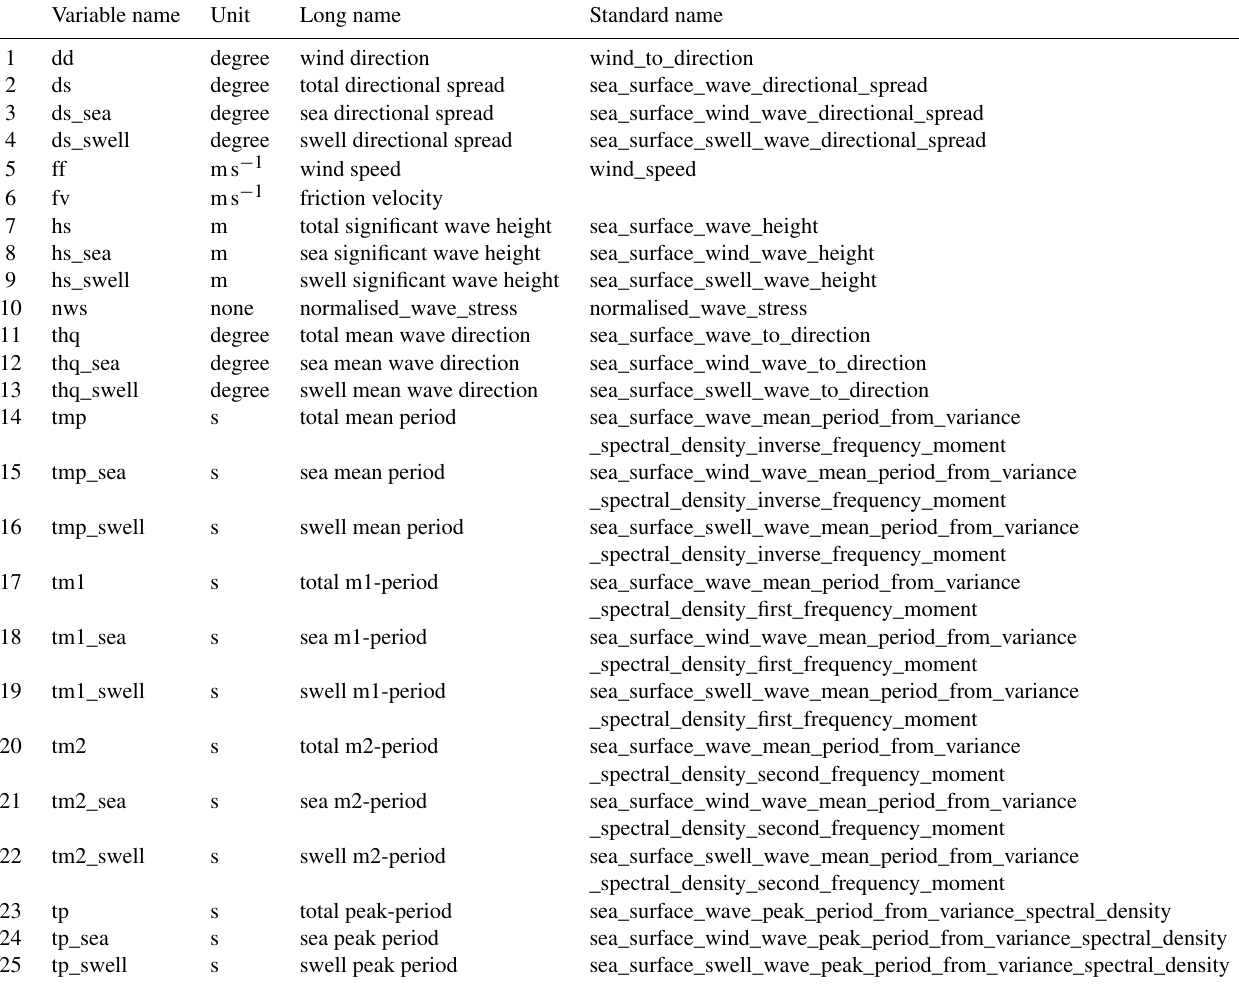
Table B1. List of available